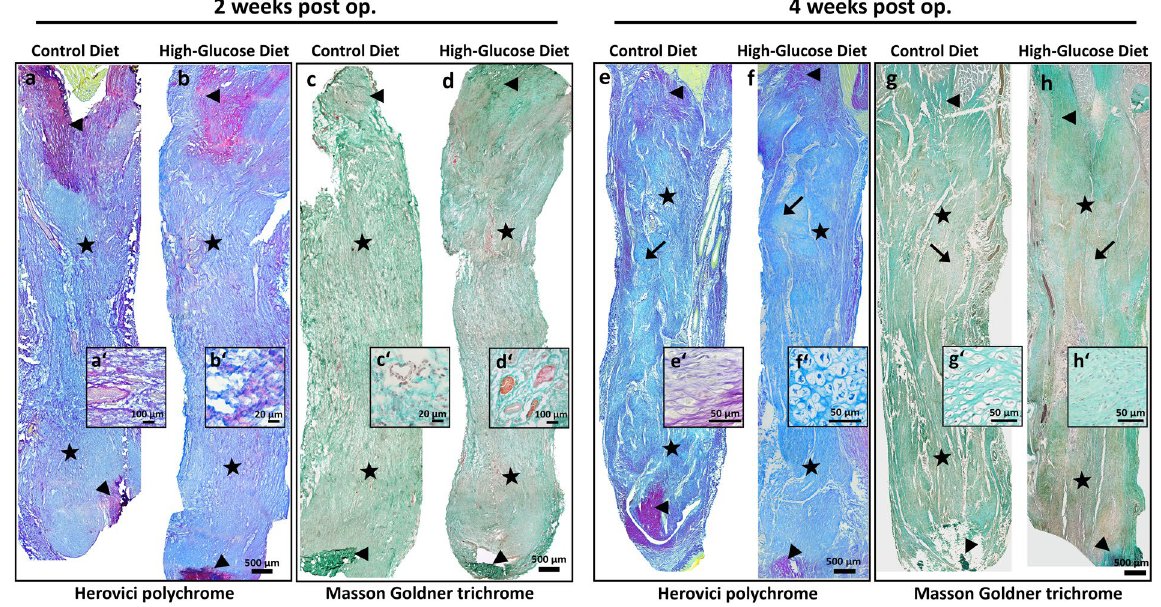
Figure 4. Descriptive histology of tendon repair tissues 2 and 4 weeks post-surgery. Representative histologic images of tendon repair tissue sections of the control diet group and the high-glucose diet group stained with either Herovici’s polychrome ( a , b , e , f ), or Masson-Goldner trichrome ( c , d , g , h ). Loose collagen fibre orientation (c’), hypercellularity and ingrowth of vessels and nerves after 2 weeks (d’). The extracellular matrix (ECM) was mainly composed of immature collagen, most likely corresponding to collagen type III (( a , b , e , f ); blue staining), both 2 and 4 weeks after surgery. Aggregates of cells with a chondrogenic phenotype ( arrows ) were frequently observed 4 weeks post-surgery in both the control and the high-glucose diet group, although to a different extent (g’,h’). No difference could be detected between the experimental groups. Arrows : retracted proximal and distal ends of the original tendon; asterisks : newly formed tendon repair